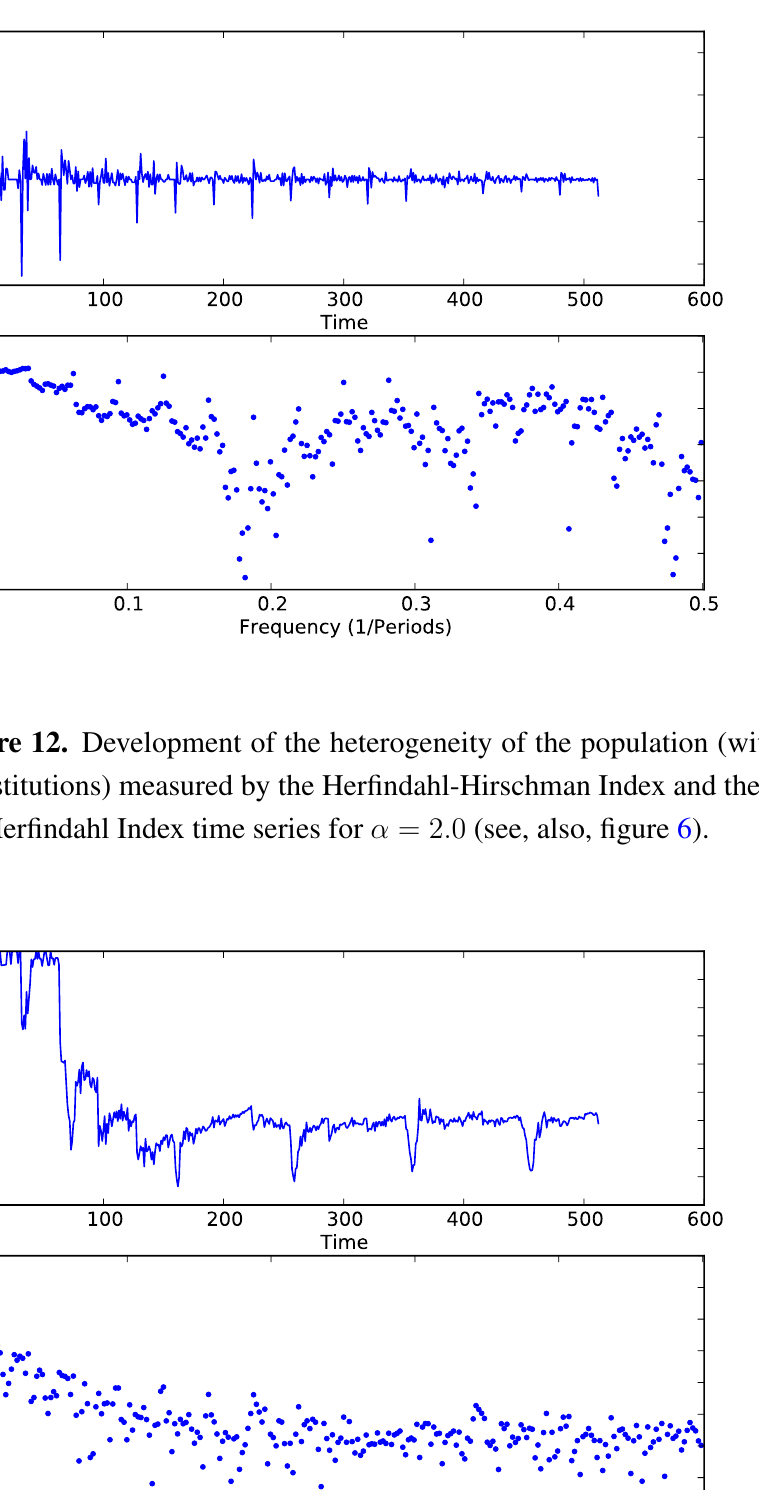
Figure 11. Development of the growth (rates) of the Herfindahl-Hirschman Index and the frequency spectrum of that time series for ↵ = 1 . 1 ).